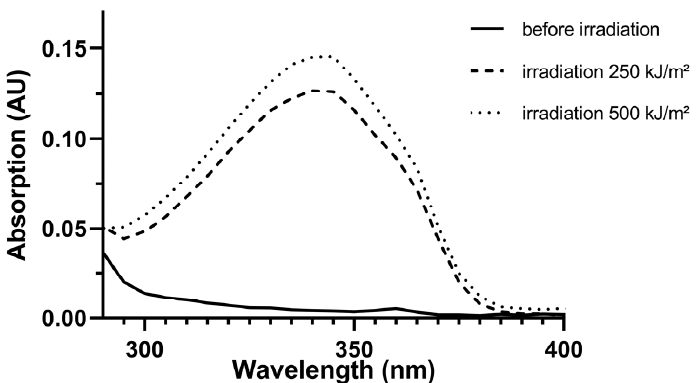
Figure 2. Absorption of UVA spectra after the photoconversion of MeO-MBM in vitro. Absorption spectra of MeO-MBM before and after UVA/B irradiation at 250 and 500 kJ/m 2 . The transformation of MeO-MBM (2%, w/w ) to avobenzone was conducted in isopropylmyristate (IPM). Absorption was measured as arbitrary units (AU) between 290 and 400 nm.